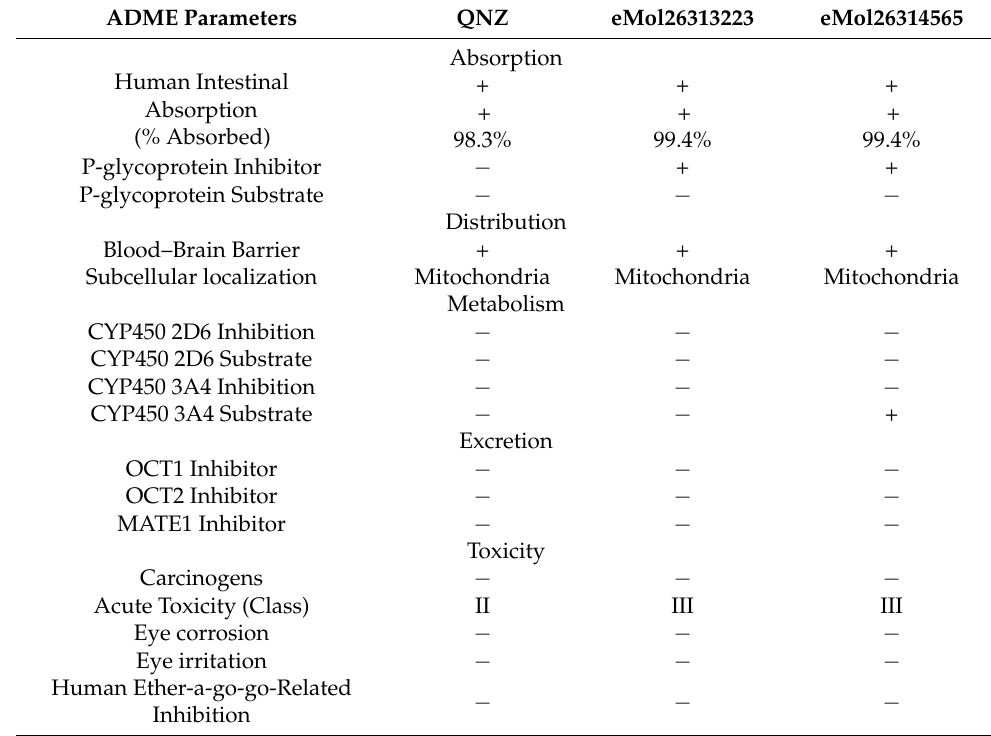
Table 5. Predicted ADMET properties of the top potent